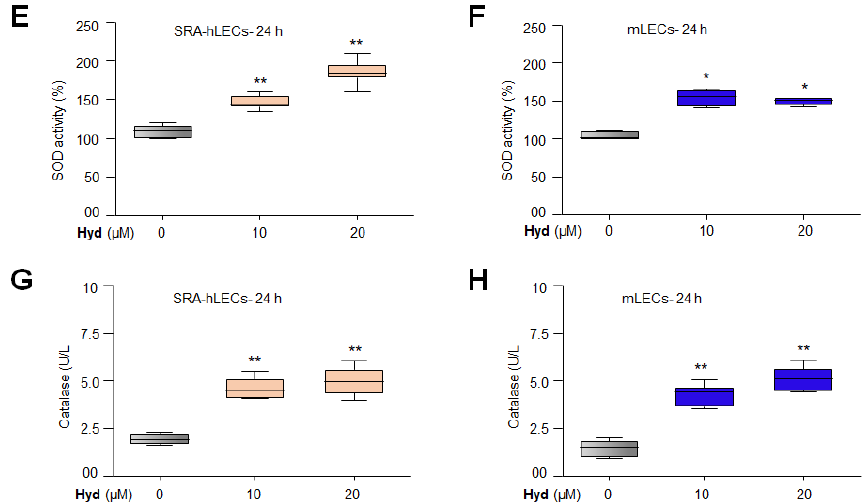
Figure 5. Hyd treatment increased the enzymatic activities of antioxidant genes significantly. Total cell lysate isolated from Hyd-treated or untreated SRA-hLECs ( A , C , E , G ) and mLECs ( B , D , F , H ) for 24 h were used to analyze the enzymatic activities as indicated. The same amount of protein was processed to measure PLA 2 (( A ) SRA-hLECs; ( B ) mLECs), GSH peroxidase (( C ) SRA-hLECs; ( D ) mLECs), SOD (( E ) SRA-hLECs; ( F ) mLECs), and catalase (( G ) SRA-hLECs; ( H ) mLECs) activities following the company’s protocols. The data represent the mean ± S.D. values of three independent experiments. Untreated vs. Hyd-treated LECs; * p < 0.05; ** p < 0.001.